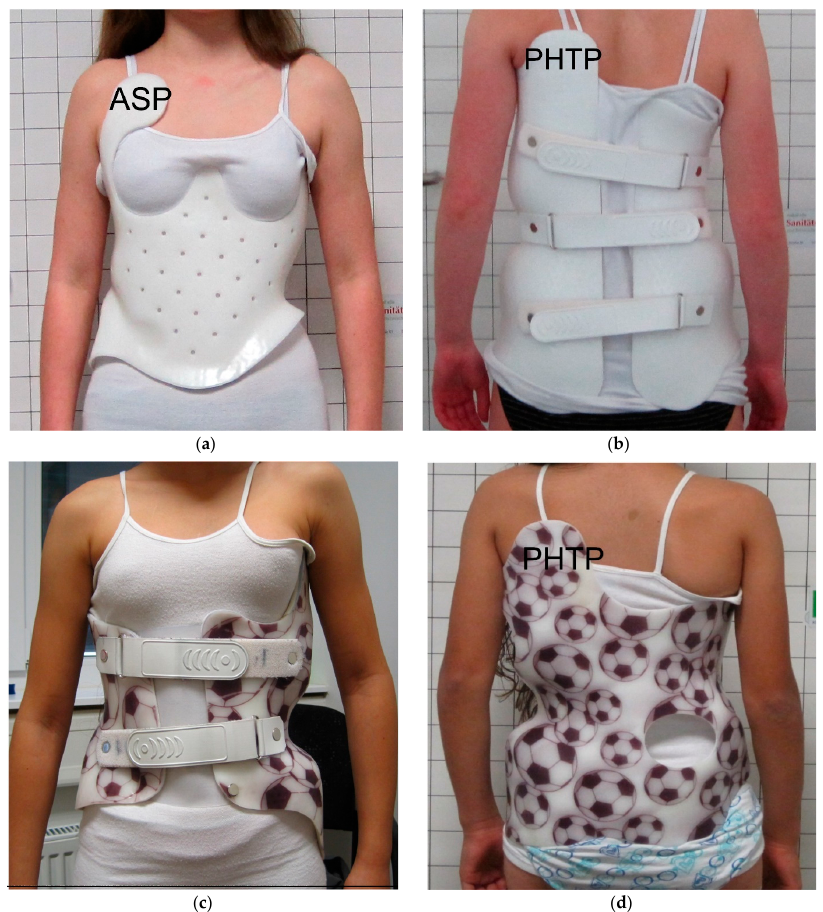
Figure 2. Examples of early and recent braces: ( a ) anterior view of an early brace from 2012, ASP marks the anterior shoulder pad; ( b ) posterior view of the same brace, PHTP marks the posterior high-thoracic pad position; ( c ) anterior view of a recent brace from 2019, ( d ) posterior view of this brace including PHTP. ASP: anterior shoulder pad. PHTP: posterior high thoracic pad As described above, the process was evolutionary. Therefore, and because of the in- dividuality of the curves and braces, not every new brace includes all modifications. Fig- ure 2 illustrates the design modifications from 2012 to 2019. The two timeframes were chosen to provide a good contrast between the new and old brace designs.